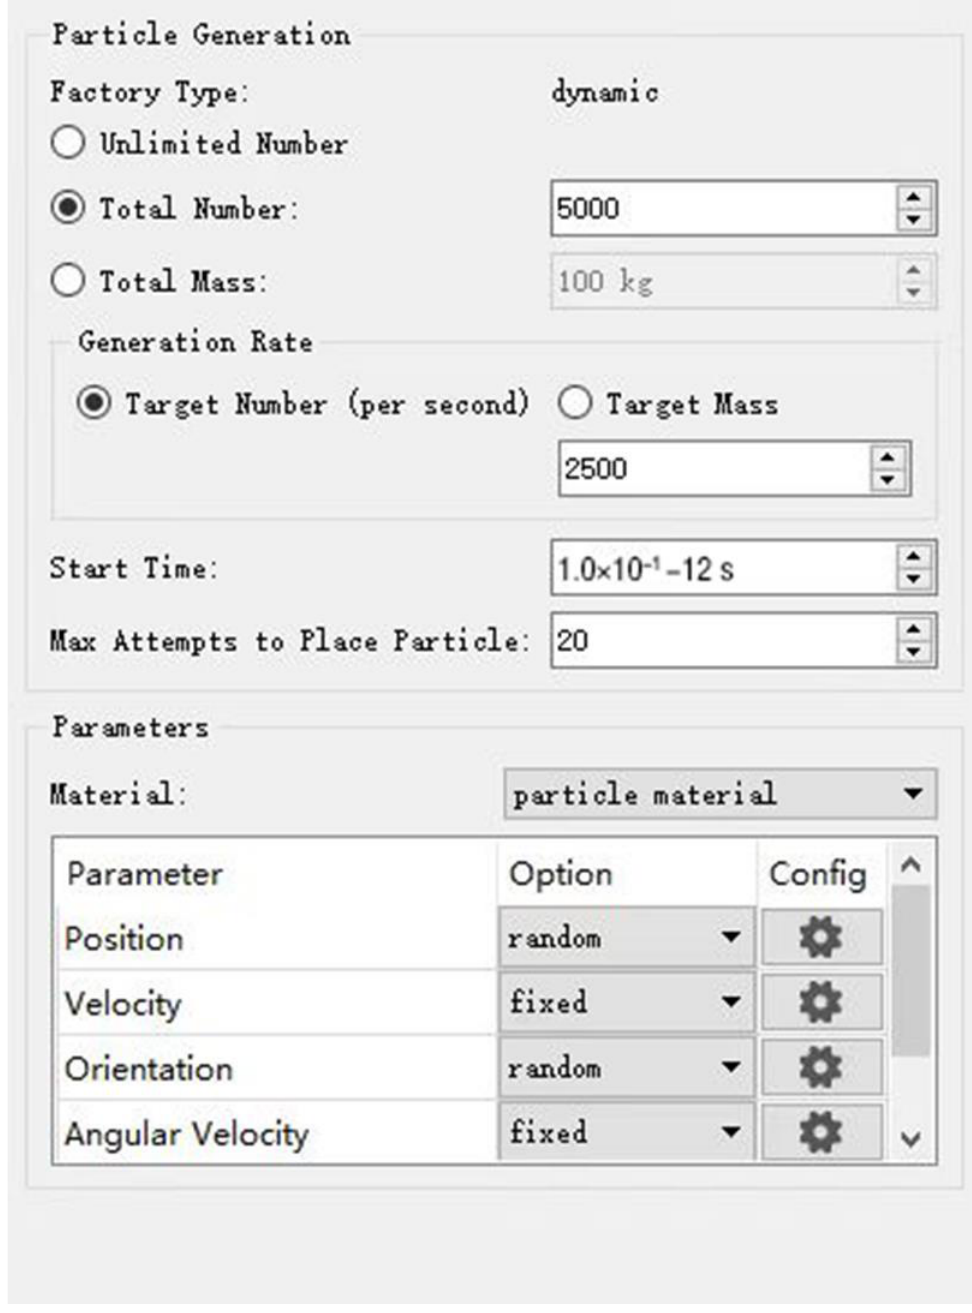
Figure 8. Particle factory Figure 8 . Particle factory settings.